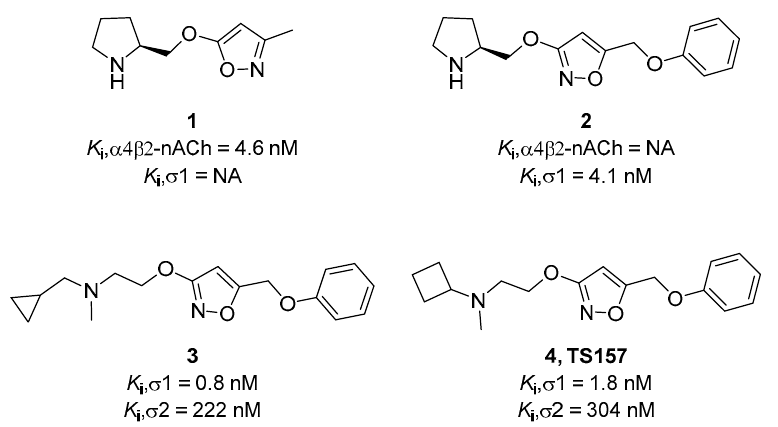
Figure 1. Chemical structures of selected